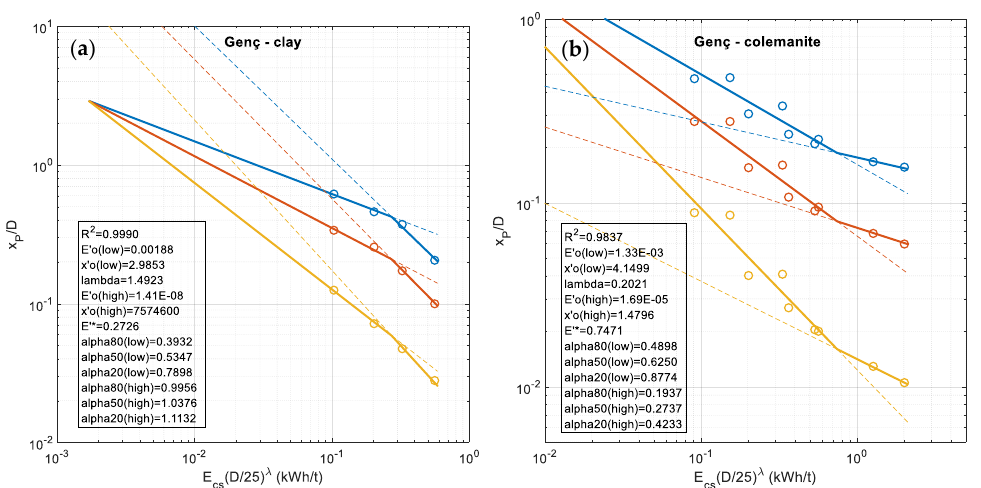
Figure A1. Double fans for Genç ’s et al. [24] clay ( a ) and colemanite ( b ). Solid lines are the actual high- and low-energy percentile lines, dashed lines are extrapolations out of their ranges of validity. Circles are data. Percentiles colors: blue — 80%, red — 50%, yellow — 20%.